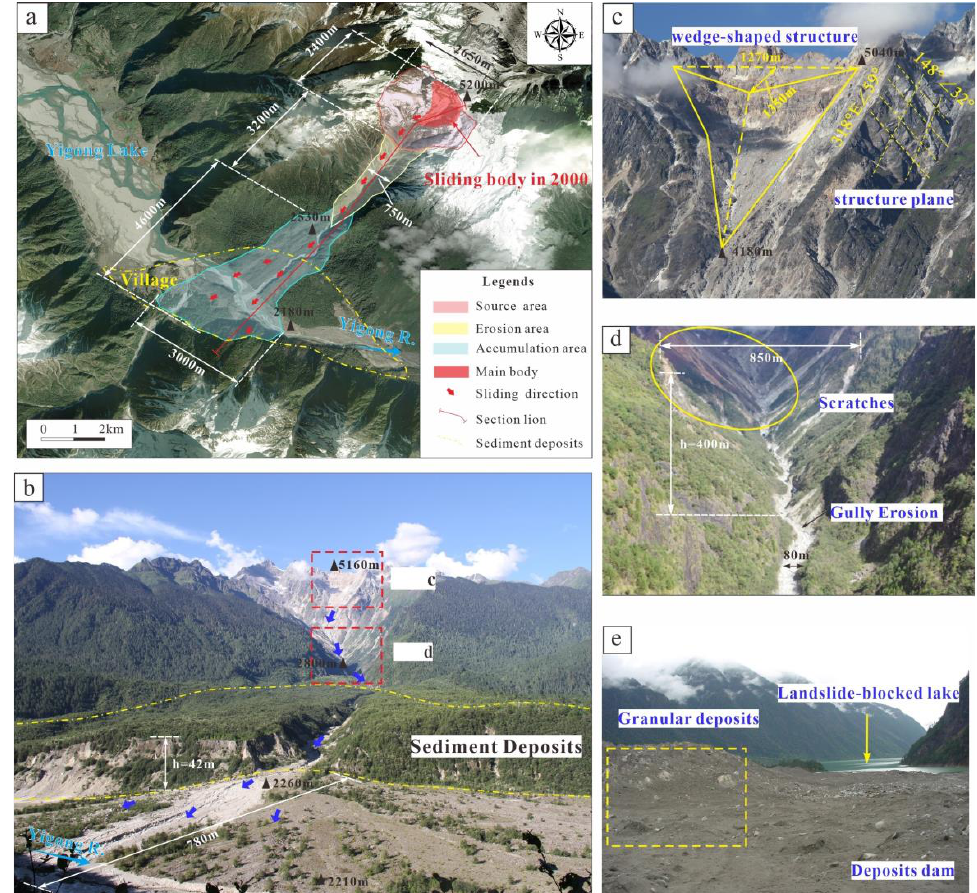
Figure 4. Major features of different areas in the Yigong gully. ( a ) the optical remote sensing images of the Yigong landslide in 2020 by Landsat 8; ( b ) general view of the Yigong landslide, taken in August 2019; ( c ) the photo of the source area; ( d ) the feature photo of the erosion area; ( e ) the feature photo of the accumulation area, taken in April 2000.